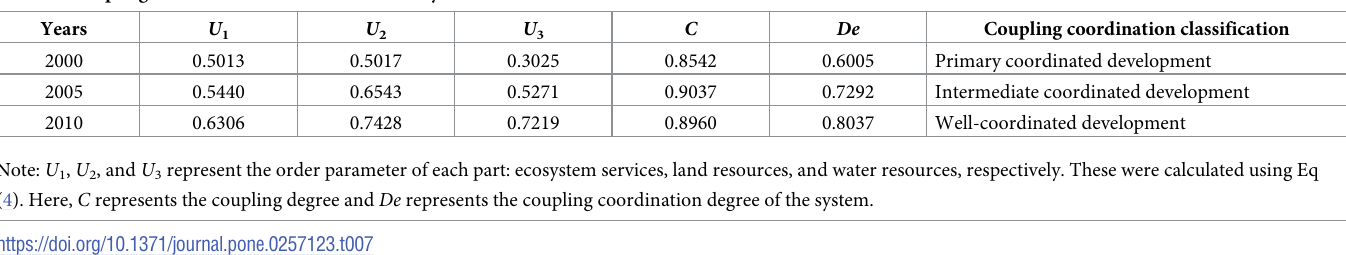
Table 7. Coupling coordination results for different